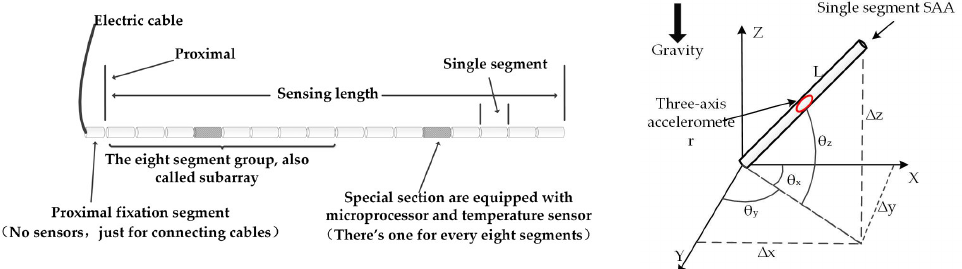
Figure 2. Structure and principle of a shape acceleration array (SAA) sensor.